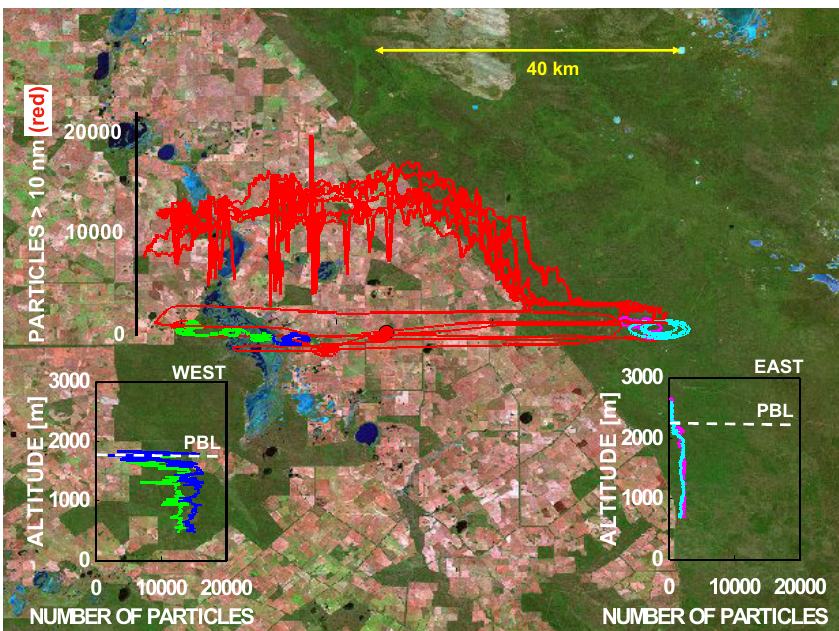
Fig. 2. Flight patterns crossing the State Barrier Fence, 9 December 2007, summer season, Number of ultrafine particles ( > 10nm, red) on six horizontal flight legs, and vertical profiles east and west of the fence (green blue and pink). Colours mark different position for horizontal and vertical flight legs. In the convective boundary layer the aerosols are well mixed with altitude (lower inserts WEST and